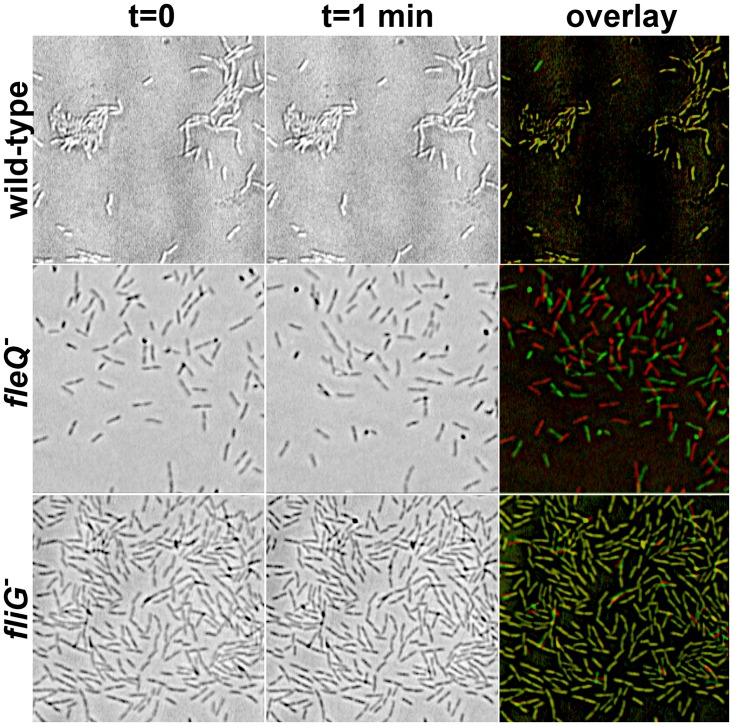
Adhesion assays of KT2442 derivatives.Phase-contrast micrographs of the wild-type strain KT2442 (top) and its fleQ and fliG mutant derivatives MRB35 (center) and MRB47 (bottom). Two frames of the same field were taken in a 1-minute interval (left and center). The right panel shows an overlay of the two images of each strain digitally colored red (t = 0) or green (t = 1 min).